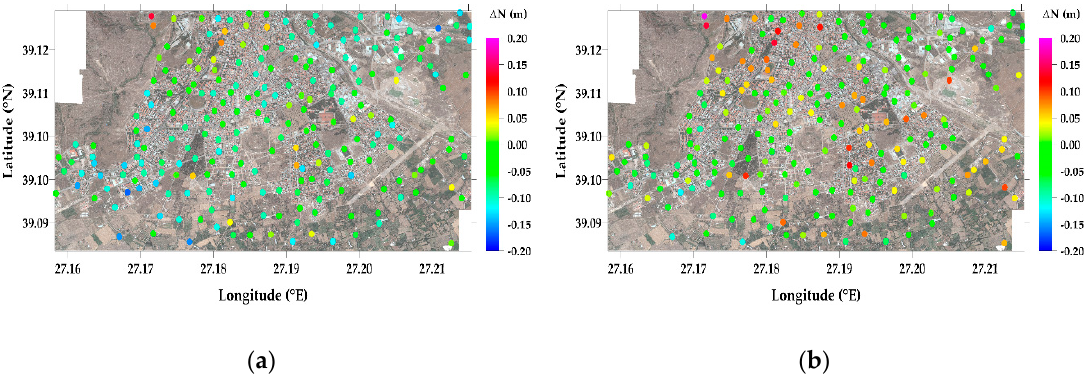
Figure 16. Point-wise distribution of geoid height differences of calculated local geoid model (interpolated from Global Mapper grid-wise solution) from ( a ) regional geoid (TG03); ( b ) global geoid (EIGEN6C4) models.